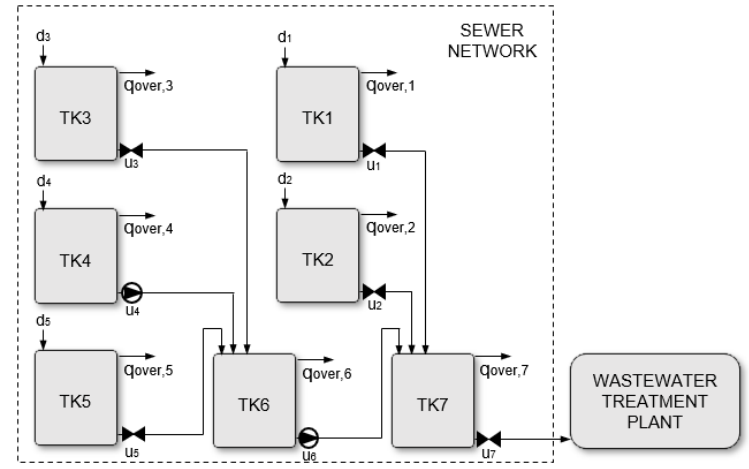
Figure 1. The structure of the sewer network.